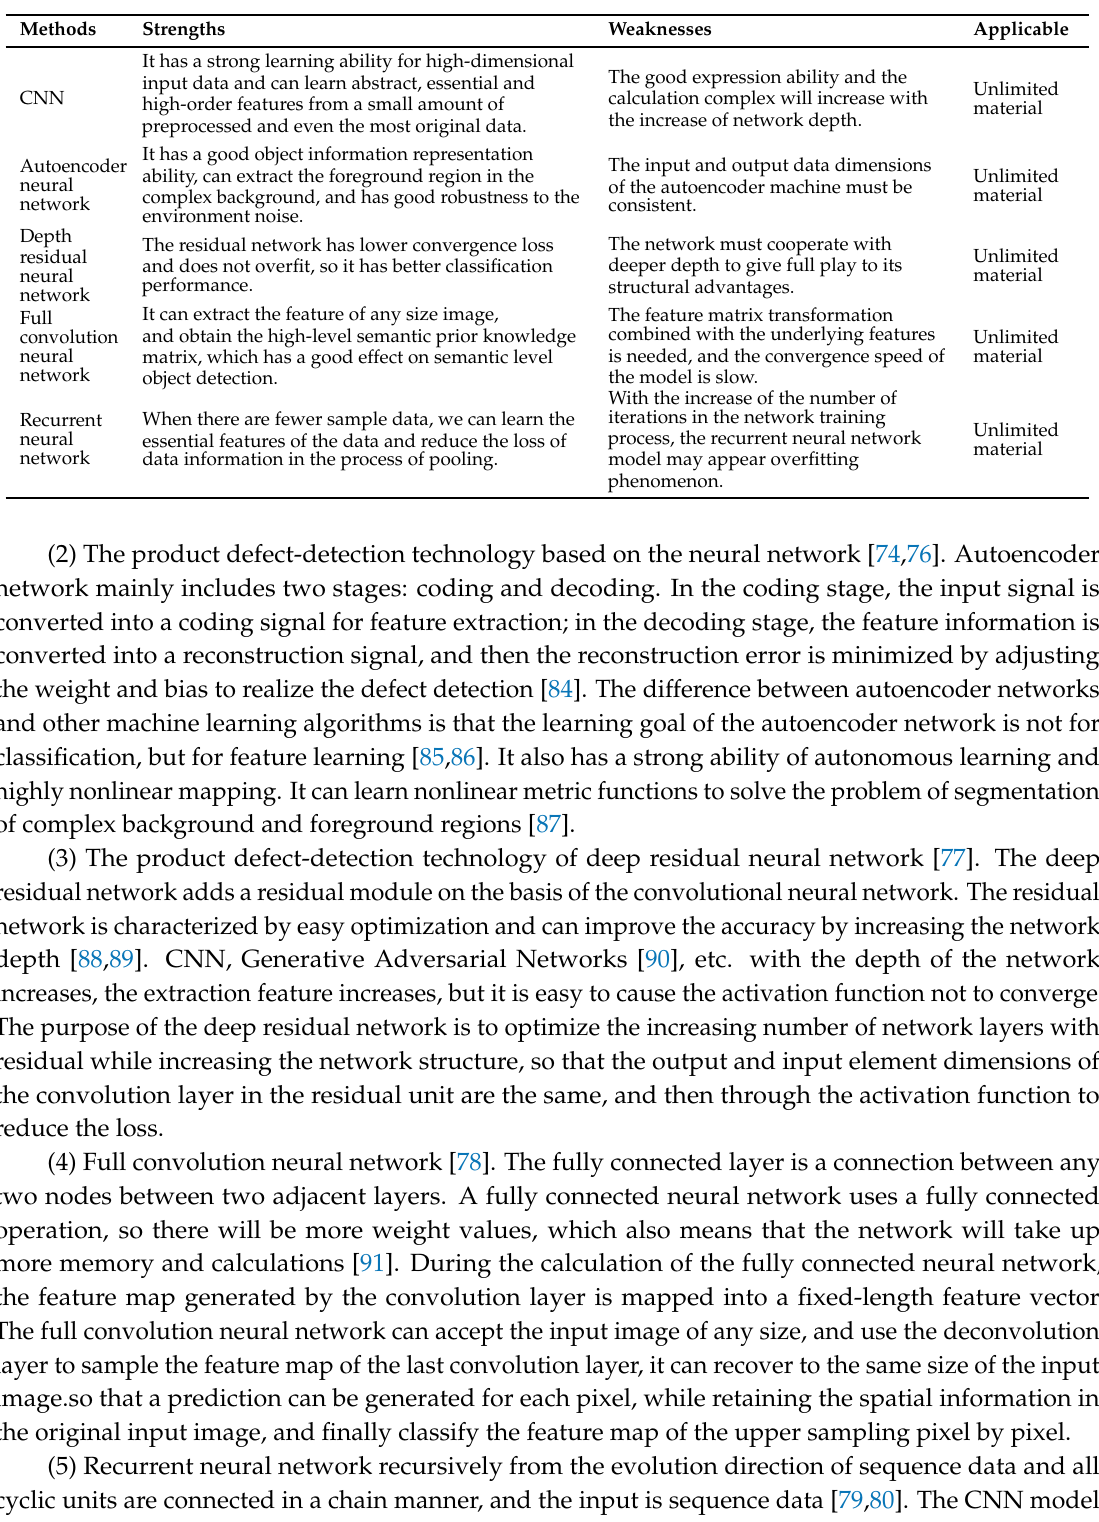
Table 2. Deep-Learning Defect-Detection